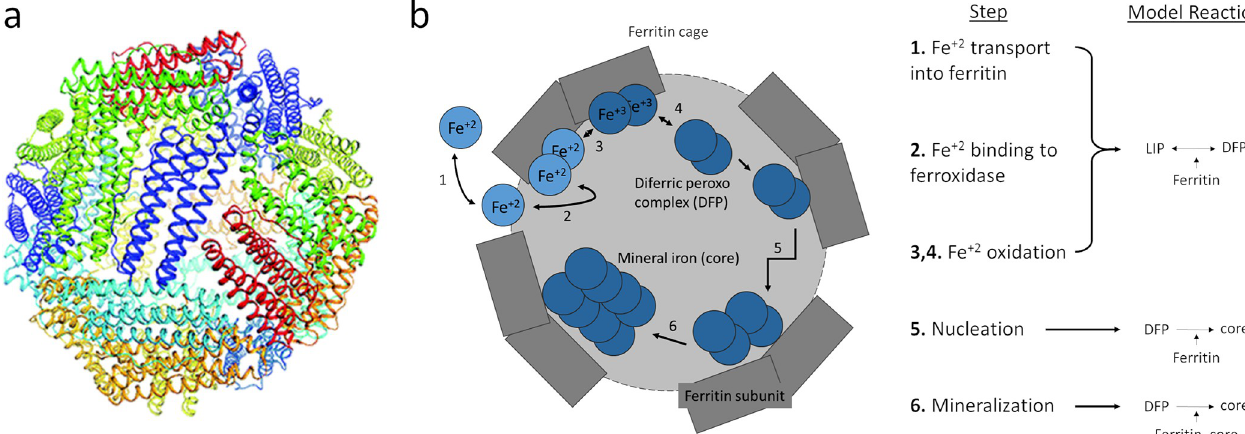
Fig 1. Model overview. a. Structure of a 24 subunit ferritin polymer cage, (reproduced from Ebrahimi et al. [43] without modification). b. Cartoon representing a single 24-subunit polymer FT cage illustrating the iron sequestration process broken up into a series of steps (as if the cage was cut in half and the dark grey rectangles signify the FT subunits with gaps for LIP transport into the cage cavity and the light grey representing the internal cavity that fills up with iron). The model represents the process of ferritin iron sequestration by approximation of the steps into four reactions, the first two of which are combined in the figure because they compose a reversible reaction. Oxidation represents the combined processes of ferrous (+2 charge, light blue) iron transport into ferritin through the three-fold pore, binding to the ferroxidase center located on H subunits, and the oxidation to the ferric state (+3 charge, dark blue, in the form of DFP), and unbinding from the ferroxidase (steps 1,2,3,4 respectively), with Reduction the reverse. Mineralization is the process of incorporating the two iron ions that are part of DFP into the mineral core (step 6). The rate of this process depends on the amount of iron already in the core. It proceeds as DFP that has unbound (step 4) from the ferroxidase reacts with the preexisting core and is incorporated into it. Nucleation represents a special case of mineralization, one where there is no preexisting core so it must be formed from several existing DFP molecules (step 5). https://doi.org/10.1371/journal.pone.0281401.g001 DFP to an existing growing crystal. Note that while the ferrihydrite that forms the core is a solid, the model species “core” accounts for the total iron in all core crystals (of all FT cages), and its value represents the concentration of iron that would be released if all the ferrihydrite crystals would be solubilized into the cytoplasm. The reactions and their kinetic properties are summarized in Table 1 and a rationale for the determination of their rate laws is outlined below. Table 1. Model mathematical representation. Shown below are the four reactions in the model, their stoichiometries, rate laws, and rate laws parameter values. The first two reactions, oxidation and reduction are parameterized from published data. Nucleation and mineralization were parameterized using parameter estimation. Reaction